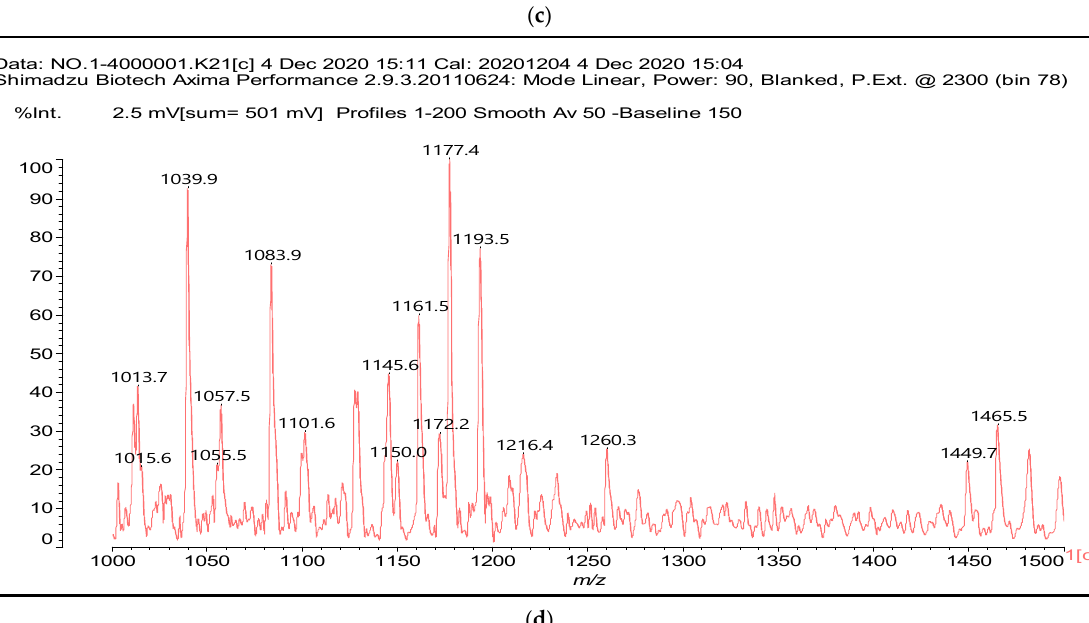
131 Da= Leucine, no Na +